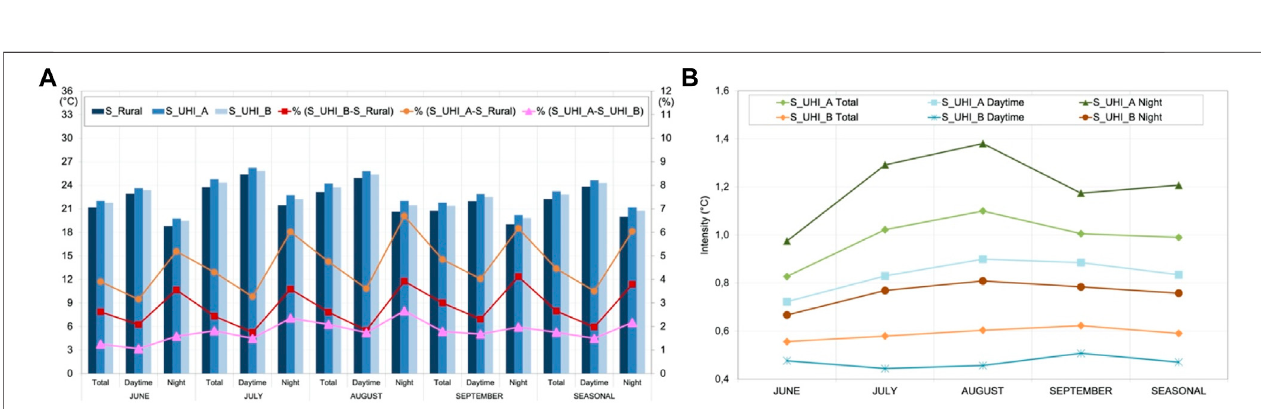
Frontiers in Energy Research |